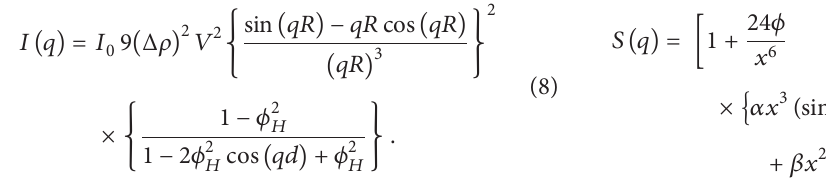
F 6: Curve �tting according to the �eubner-Strey model for P� composites loaded with (a) �, (b) ��, (c) ��, and (d) 6�wt.